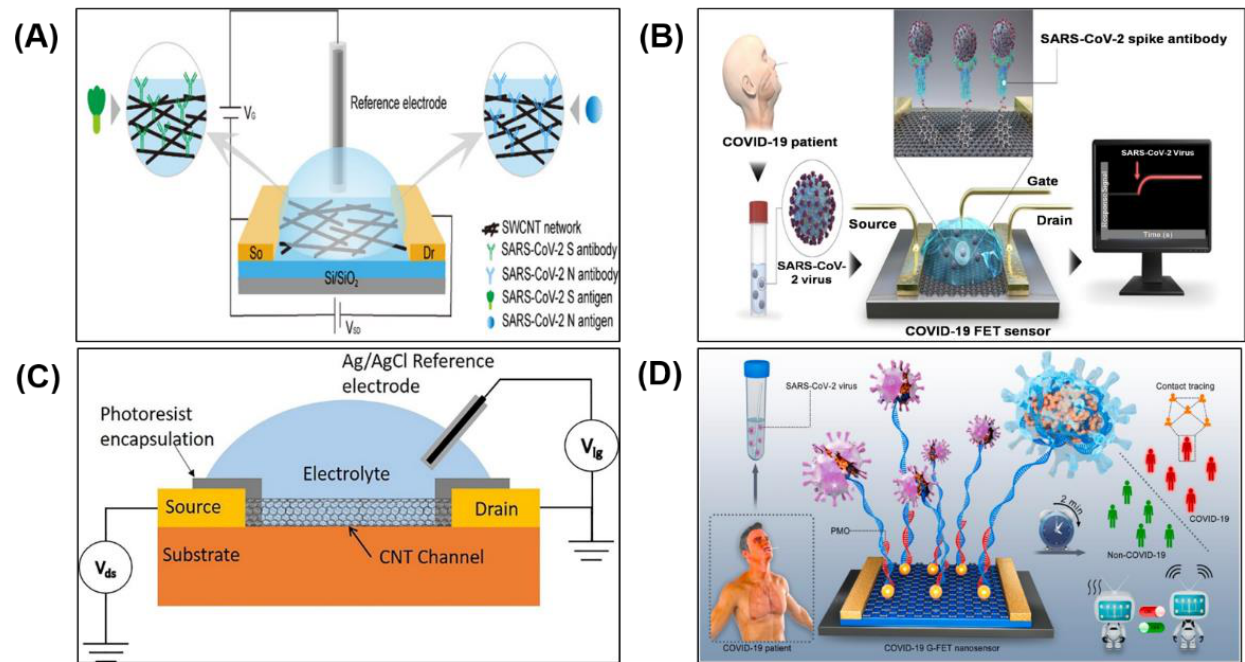
Figure 8. Field-effect transistor biosensor for COVID-19 detection. ( A ) SWCNT-based FET biosensor. Reprinted with permission from [42]. Copyright 2020, American Chemical Society. ( B ) Graphene-based FET biosensor. Reprinted with permission from [99]. Copyright 2021, American Chemical Society. ( C ) CNT-based FET fabricated on a flexible Kapton sub- strate. Reprinted with permission from [100]. Copyright 2021, Elsevier Ltd. ( D ) PMO-functionalised Graphene-FET bio- sensor. Reprinted with permission from [106]. Copyright 2021, Elsevier B.V.